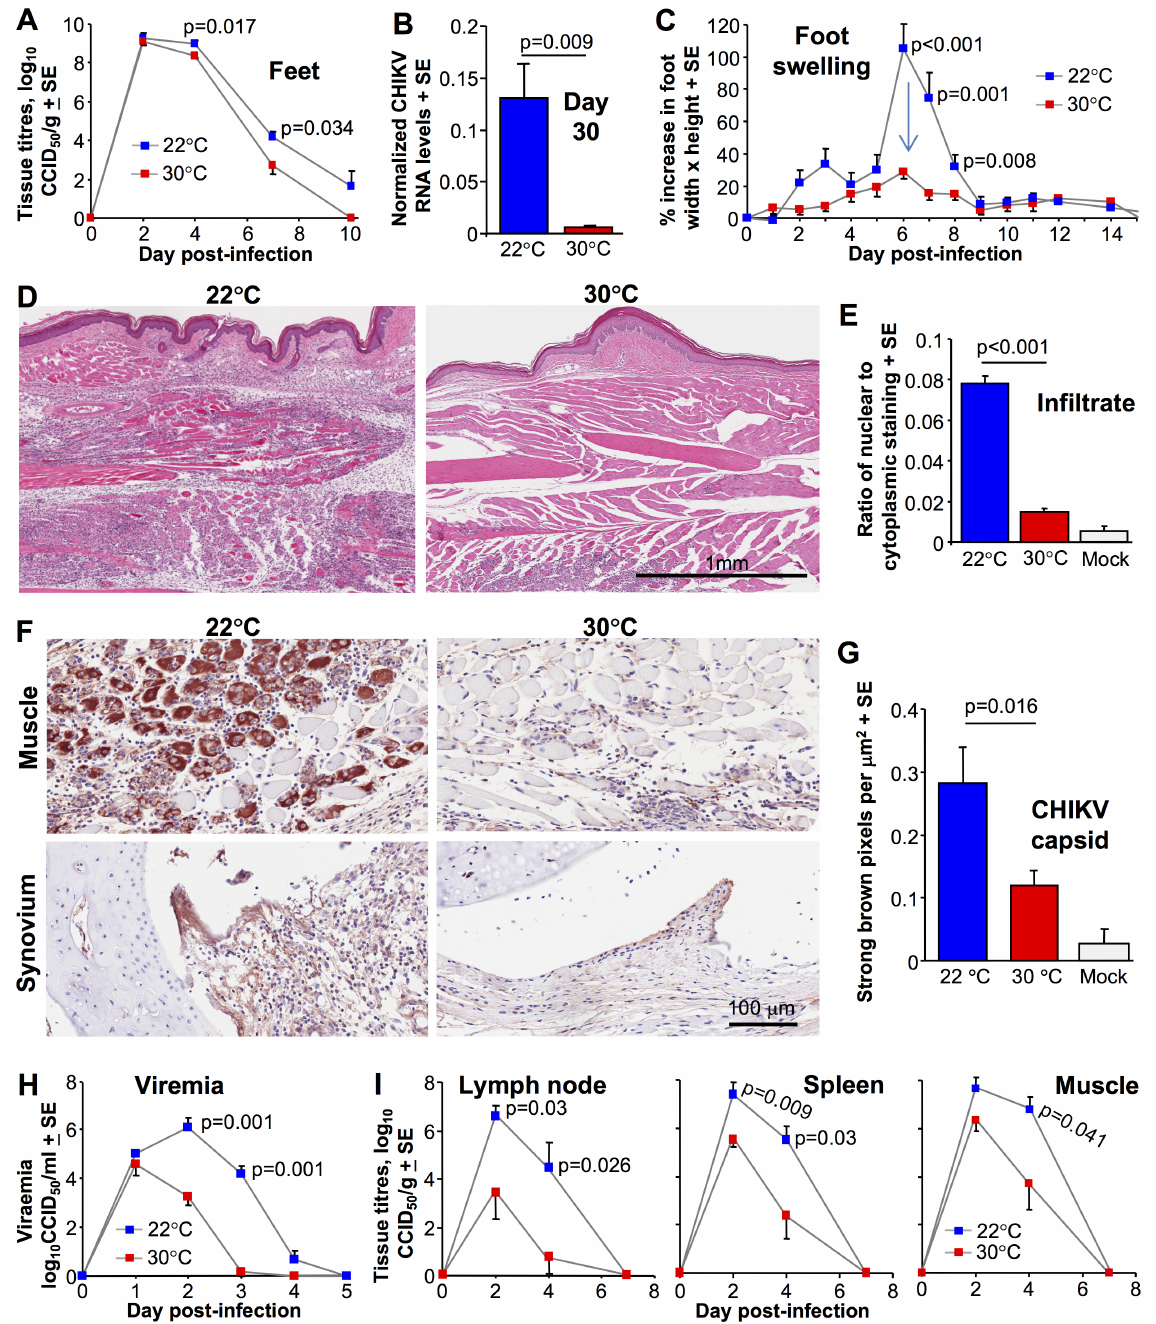
Fig 1. The effect of ambient temperature on CHIKV infection and disease. (A) CHIKV titers in feet of mice held at 30˚C or 22˚C after CHIKV inoculation s.c. into the feet. (Statistics by t test, day 4 or Kolmogorov-Smirnov test, day 7, n = 12/16 feet from 6/8 mice per group, data was obtained from two independent experiments). (B) Relative CHIKV RNA levels in feet on day 30 post infection. RNA levels normalized to RPL13A. (Statistics by Kolmogorov-Smirnov test, n = 6 feet from 6 mice per group). (C) Foot swelling for mice housed at 30˚C or 22˚C (Statistics by Kolmogorov-Smirnov or Mann-Whitney U tests, n = 12–16 feet from 6–8 mice per group, data was obtained from two independent experiments). (D) Examples of H&E staining of arthritic feet day 7 post infection for mice housed at 22˚C and 30˚C. At 22˚C blue staining nuclei of infiltrating cells can be seen throughout the section. At 30˚C blue staining nuclei of infiltrating cells are less abundant, with a patch evident bottom middle/left of the section. (E) Aperio pixel count quantification of the leukocyte infiltrates (exemplified in D), expressed as a ratio of nuclear to cytoplasmic staining ratios; (infiltrating leucocytes have relatively high nucleus to cytoplasm ratios [36]). N = 6 mice and feet per group, with 3 sections per foot used to produce a mean for each animal; statistics by t test. (F) Immunohistochemistry of muscle and